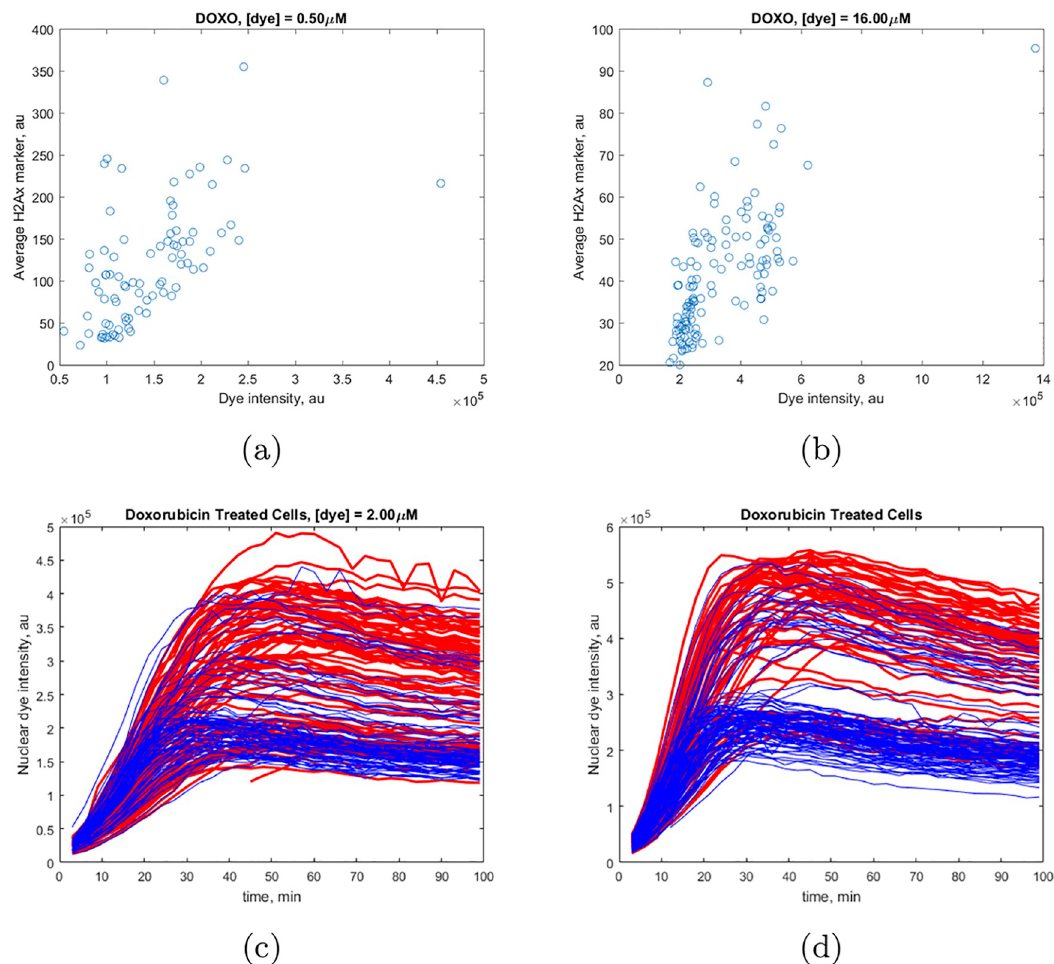
Fig 8. Extent of DNA damage due to doxorubicin treatment vs. Hoechst dye incorporation. Cells were incubated with [ Dox ] = 1 μM and (a) [ dye ] = 0.5 μM or (b) [ dye ] = 16 μM correspondingly. Time traces of individual cells incubated with [ Dox ] = 1 μM and (c) [ dye ] = 2 μM or (d) [ dye ] = 4 μM . Blue colored traces correspond to a lower extent of DNA damage as determined using the marker γ -H2Ax. Red colored traces correspond to a higher extent of DNA